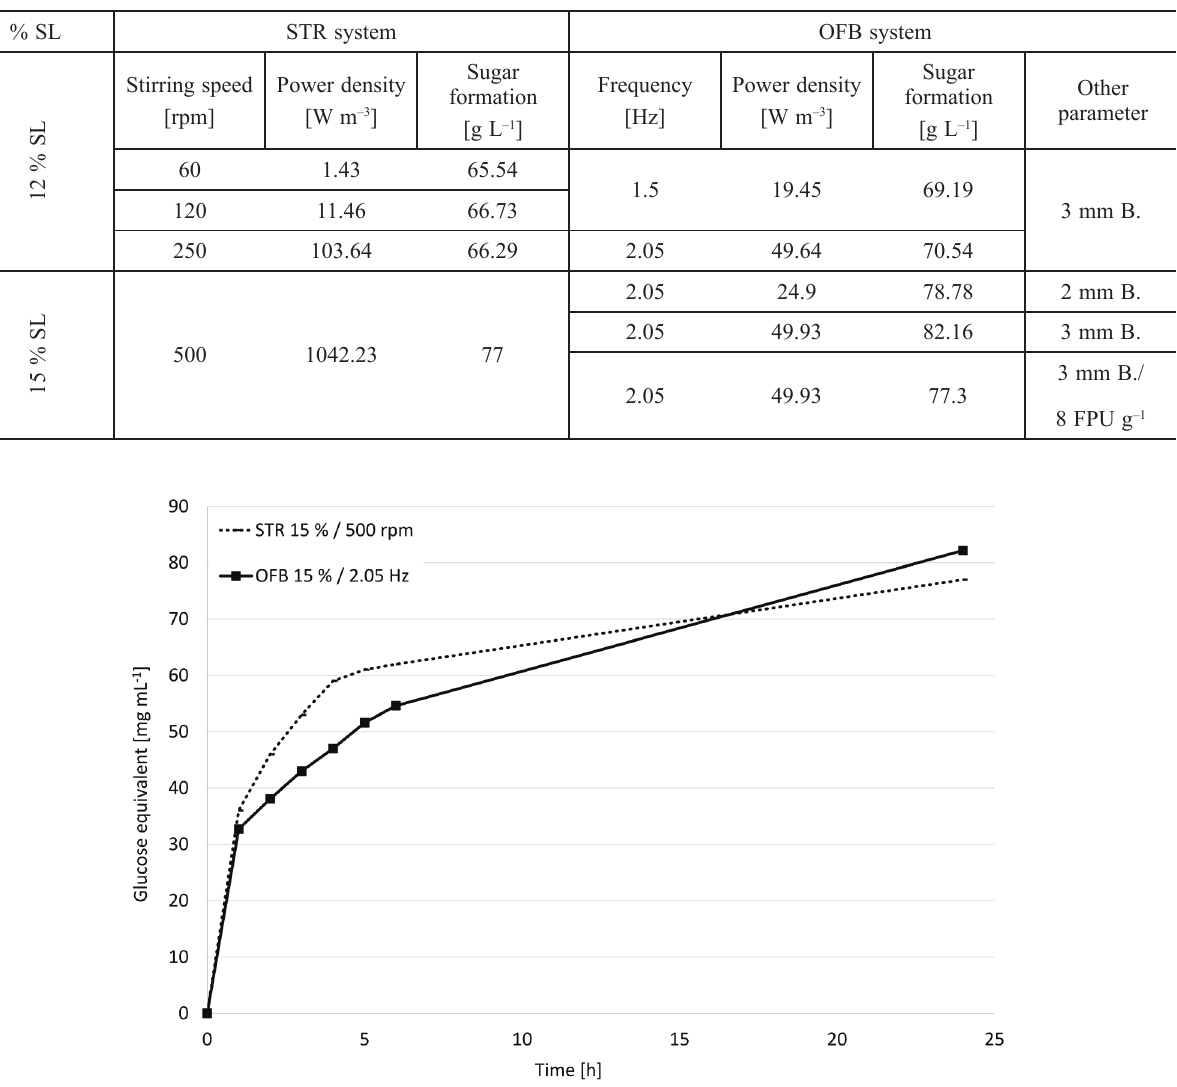
Fig. 11 – Comparison of enzymatic hydrolysis of STR and OFB (15 % SL; α-cellulose, 50 °C, 24 h, OFB: 2.05 Hz, 10 mm amplitude, 3 mm baffle, STR: 500